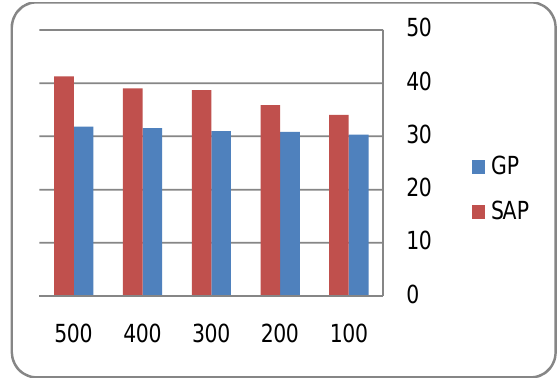
Fig. 4. Comparison between GP and